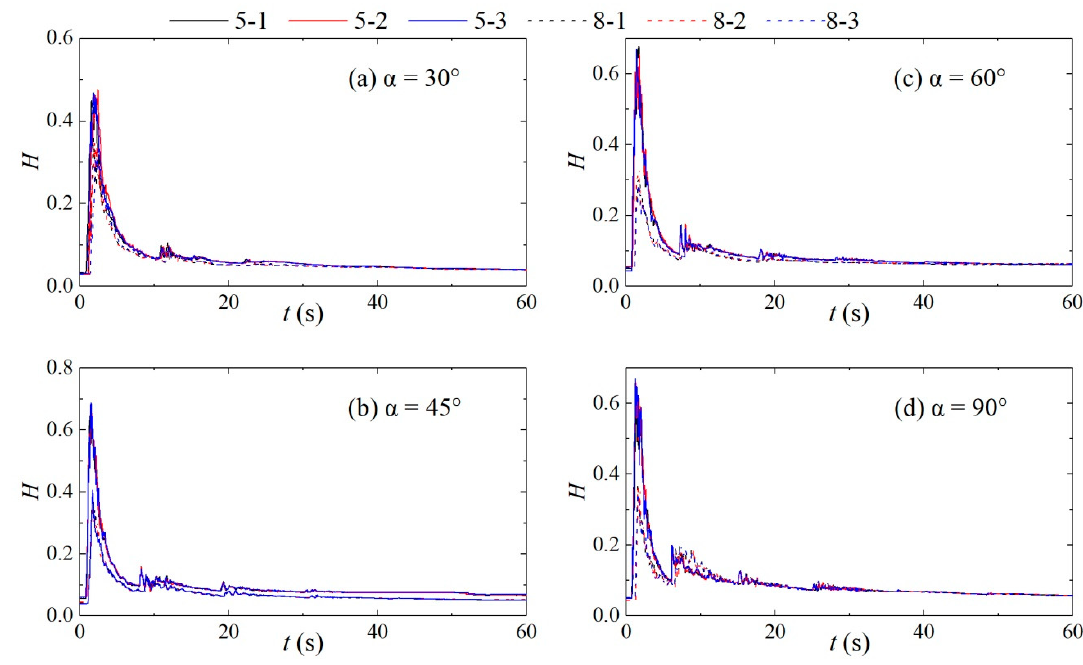
Figure 5. Variations in the water depth at measuring points #5 and #8. ( a ): α = 30 ◦ ; ( b ): α = 45 ◦ ; ( c ): α = 60 ◦ ; ( d ): α = 90 ◦